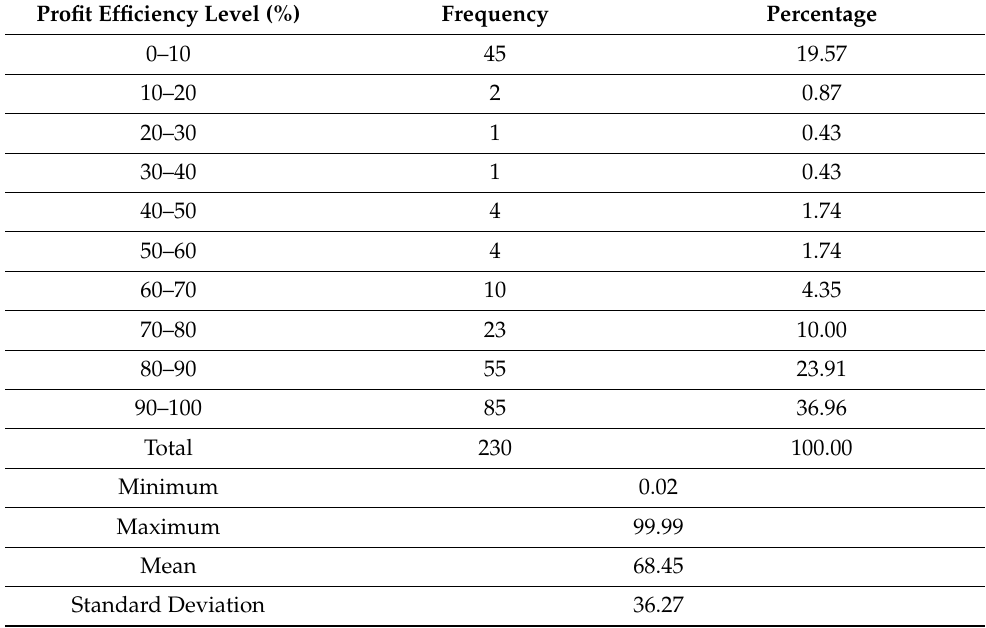
Table 4. Distribution of profit